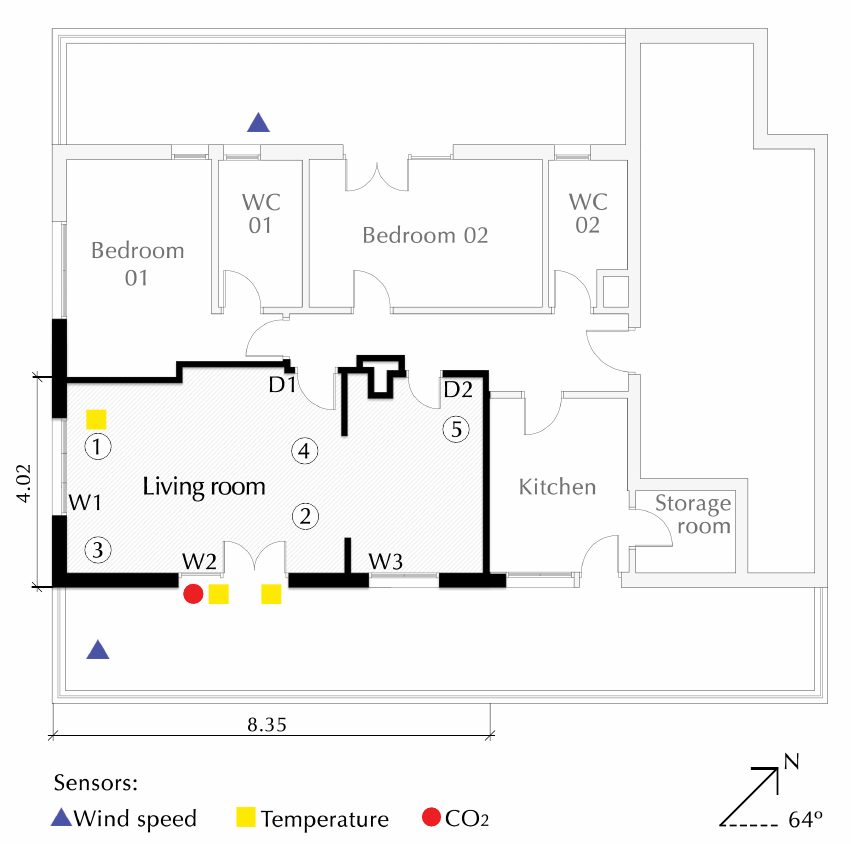
Figure 3. Plan of the apartment. W, window; D, door. Numbers are CO 2 sensors. Sensor 1 was installed at 0.40 m above the ground; sensor 2 at 0.74 m; sensor 3 at 1.19 m; sensor 4 at 0.74 m, and sensor 5 at 1.52